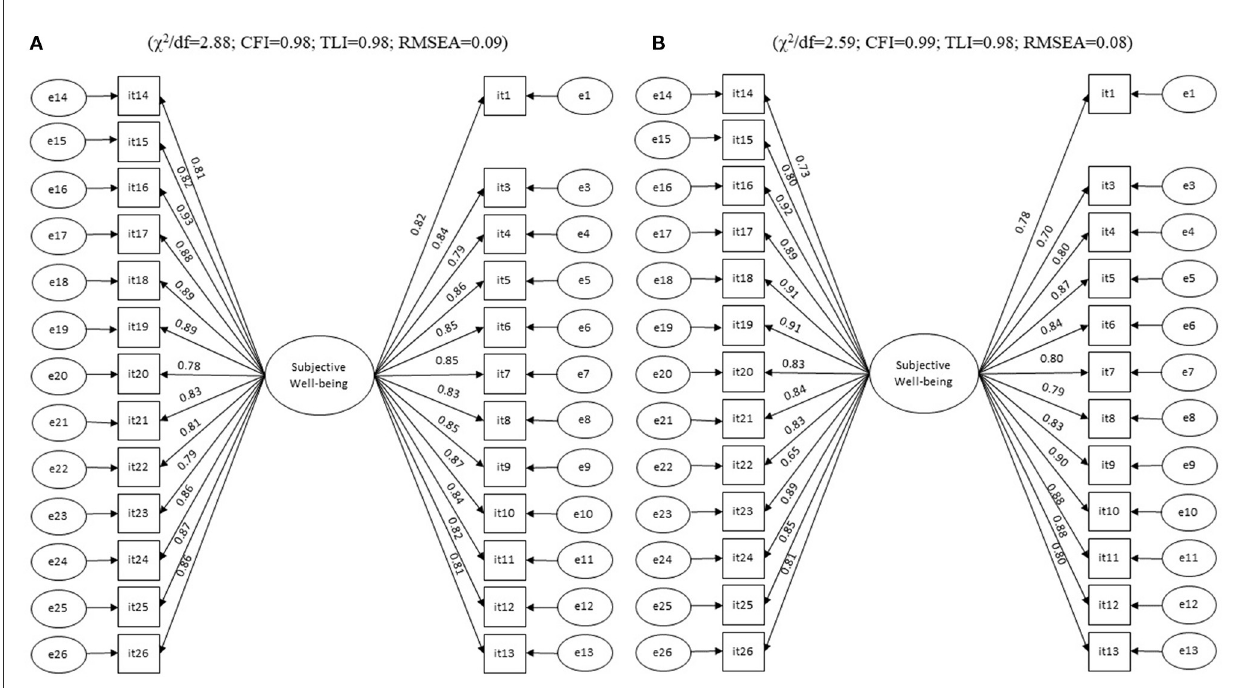
FIGURE2 Factorial model fitted for the test sample ( n = 212) (A) and validation sample ( n = 231) (B) of preschool children.